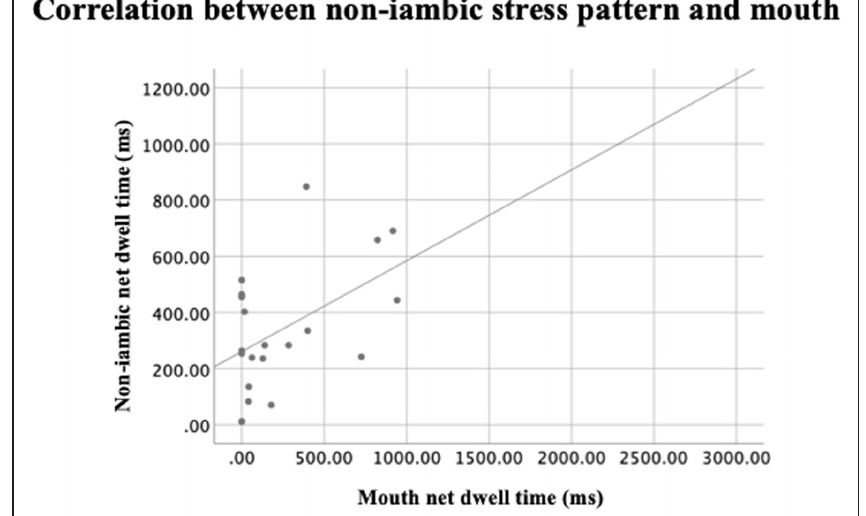
Figure 4: Correlation between looking time (net dwell time – ms) to the non-iambic stress patterns and eye gaze (net dwell time – ms) to the mouth.